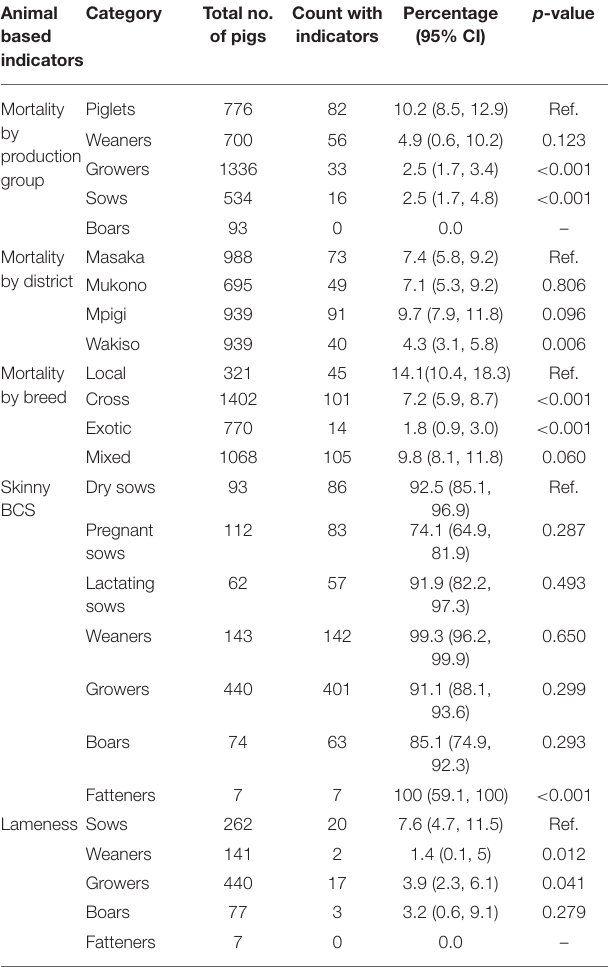
TABLE 4 | Mortality, BCS and lameness. Animal based